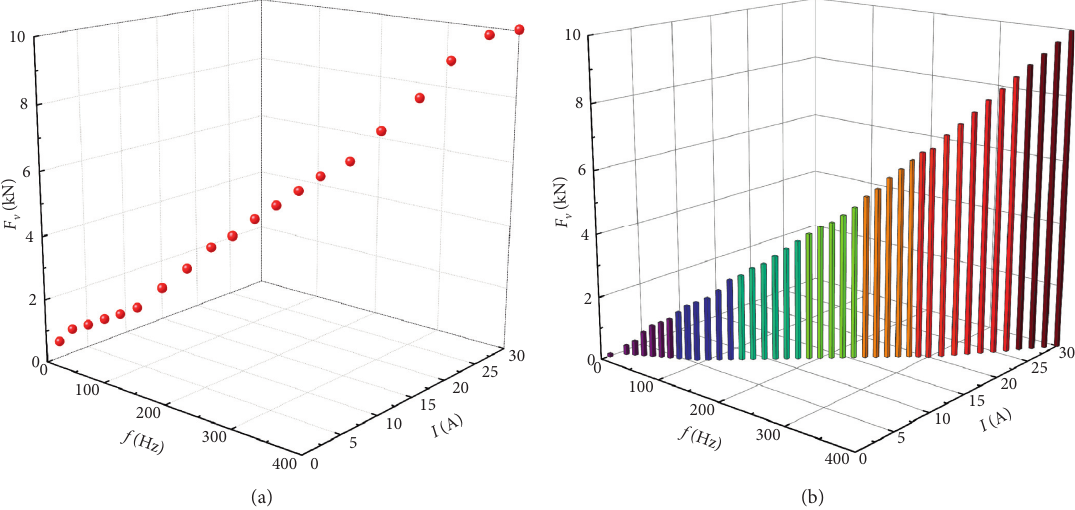
Figure 9: Excitation force at different frequency and current. (a) Magnetic field intensity-magnetization. (b) Magnetization-magneto- striction